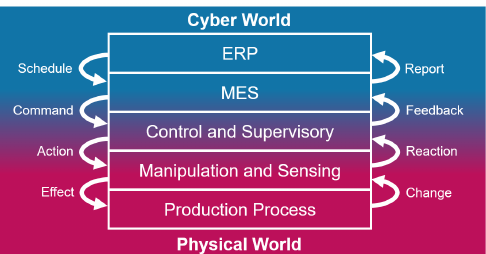
Figure 3. Projection of the CPS concept on the ISA95 levels. [Source: Own figure].